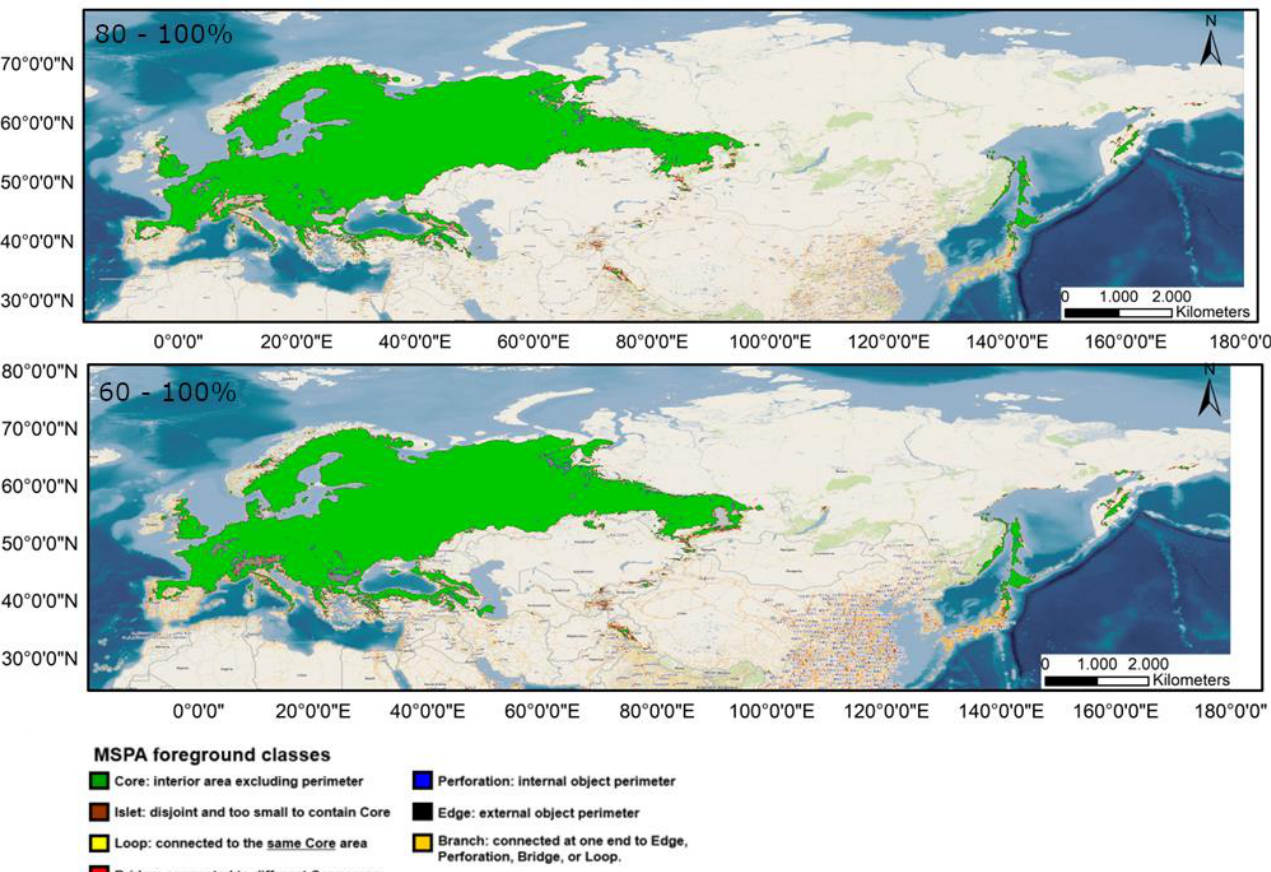
Figure 3. Results of the MSPA analysis for the current situation for distributions 80 – 100% ( up ) and 60 – 100% ( down ). 60–100% ( down